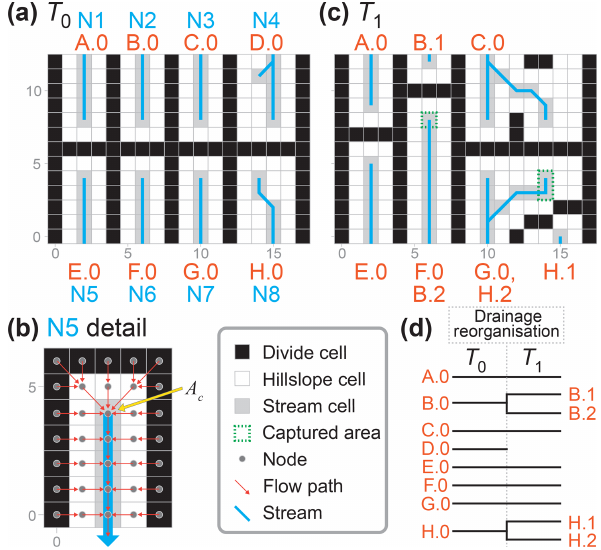
Figure 3. Downscaled schematic of the modelling approach. (a) A schematised steady-state landscape wherein the main divide sepa- rates eight stream networks (N1... N8) that each flow to either the north or south boundary. (b) The species and zones of SpeciesE- volver are defined at the nodes of a Landlab grid. In this study, nodes with a drainage area greater than A c define the zone of a species. (c) The landscape following reorganisation. N6 and N7 captured areas from adjacent networks. While N3 did extend into the water- shed of N4, it did not overlap the stream nodes of the prior time step; therefore, N3 did not capture N4 following the strict definition of capture in this study. N4 disappeared because all nodes in the northeast watershed have a drainage area below the critical drainage area. (d) The phylogenetic tree of the species in (a) and (c)